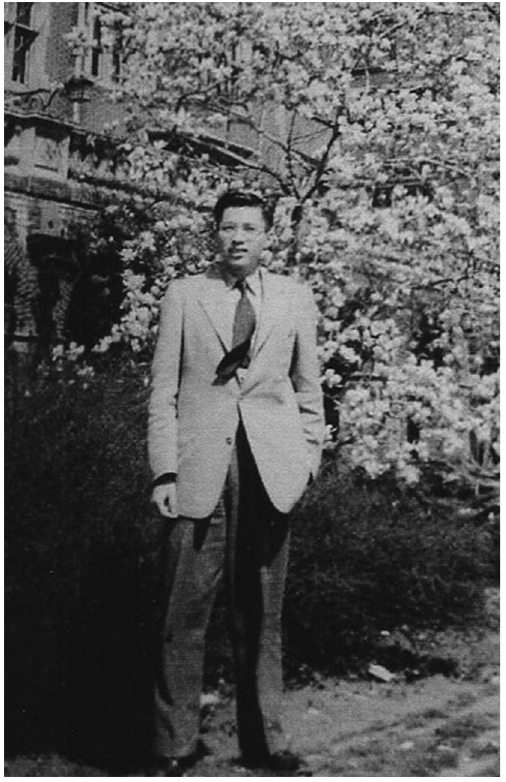
Figure 1. Dr. Ray Wu in the University of Pennsylvania in